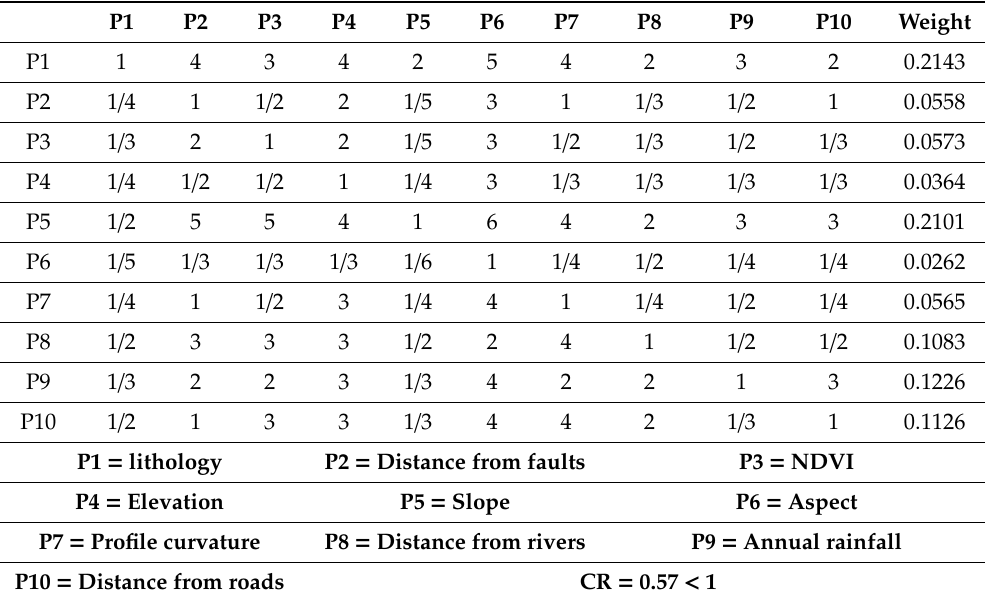
Table 2. AHP judgement matrix of the landslide-a ff ecting